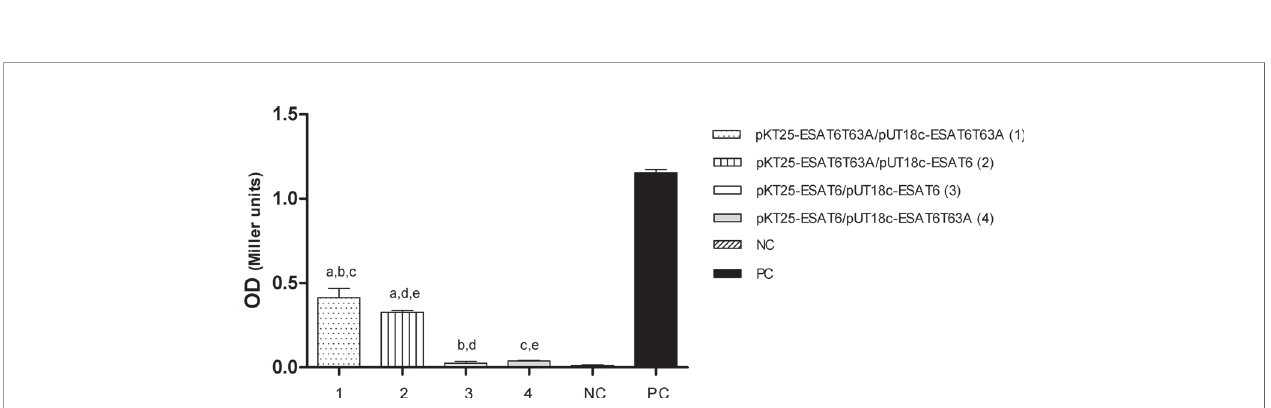
FIGURE 9 | In vivo interaction of ESAT-6 alleles. Protein interactions were determined by using a bacterial two- hybrid assay. E. coli BTH 101 cells were transformed with the plasmids described in the fi gure and the b -galactosidase activity was measured as described in M&M. The bars represent b -galactosidase activity, expressed as Miller units [A420x1000/reaction time (min)xA600] ± S.D. of triplicate. Plasmids pUT18c-ESAT-6 and pkT25-ESAT-6 are respectively pUT18c and pKT25 vectors carrying ESAT-6 WT. Plasmids pUT18c-ESAT-6T63A, and pkT25-ESAT-6T63A are respectively pUT18c and pKT25 vectors carrying ESAT-6T63A. NC, negative control; PC, positive control. (Statistical analysis was performed using ANOVA and Bonferroni post test to compare among the different plasmid constructions). a: signi fi cant difference between 1 and 2 (p<0.05); b: 1 and 3 (p<0.0001); c: 1 and 4 (p<0.0001); d: 2 and 3 (p<0.0001) and e: 2 and 4